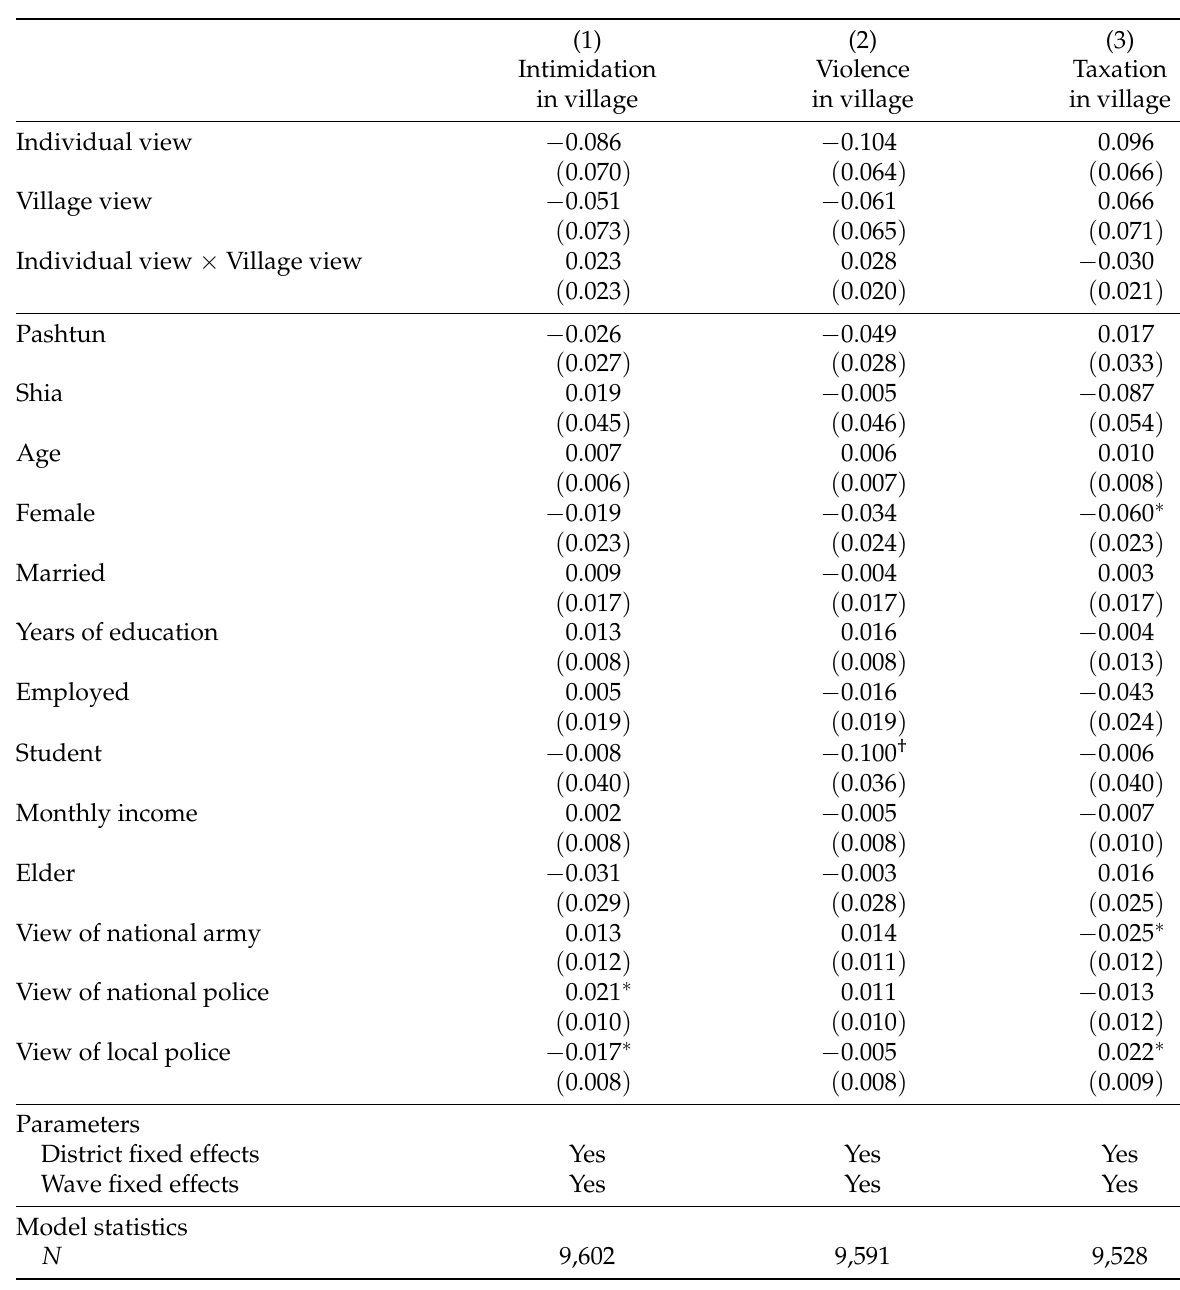
Table 5: Assessing balance in the probability of exposure to type of wrongdoing with respect to individual and village views of the